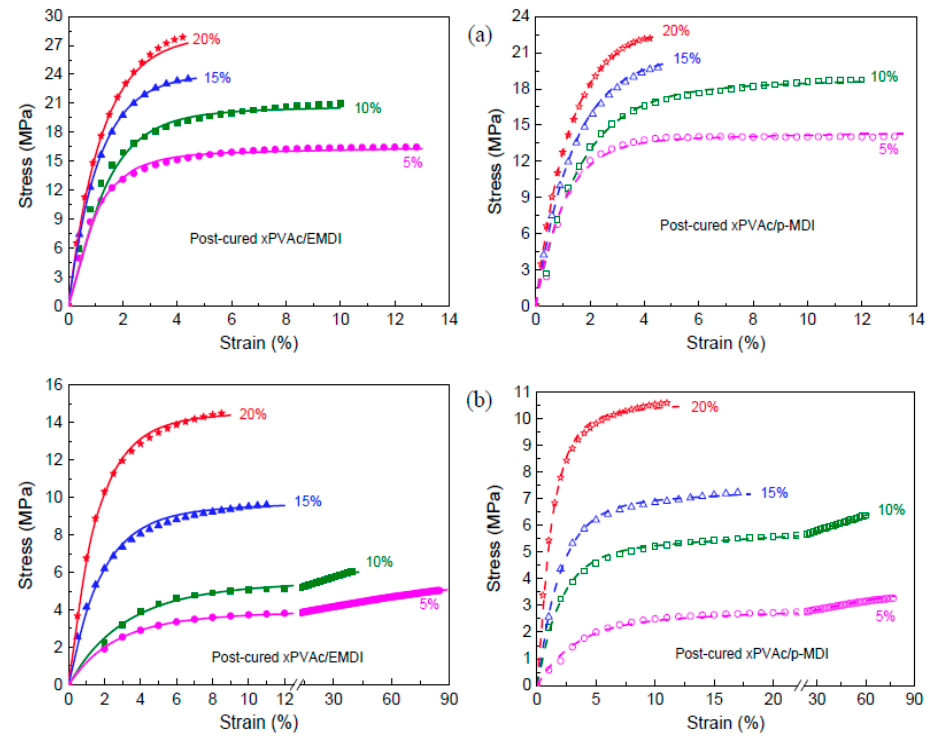
Figure 6. Representative stress-strain curves of post-cured EPI film at ( a ) 0% RH and ( b ) 80% RH (dot: experimental data, solid line: calculated by Equation (2)).